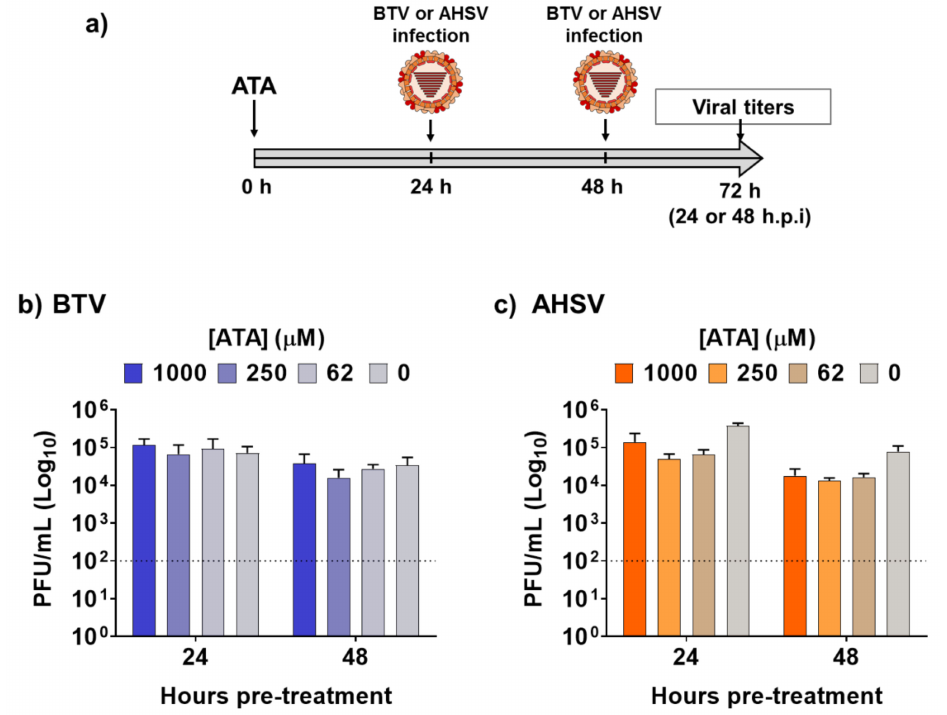
Figure 3. Pre-treatment with ATA did not prevent infection by BTV or AHSV. ( a ) Schematic representation of the experimental design. Vero cells were pre-treated with the indicated concentrations of ATA for 24 or 48 h before infection (MOI, 0.01) with BTV ( b ) or AHSV ( c ). At 24 h.p.i, tissue culture supernatants were collected for virus titration by the plaque assay. Data re expressed as mean and SD. Dotted lines indicate the limit of